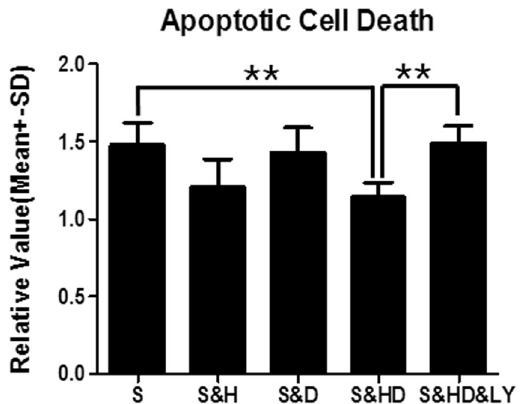
Figure 4. Alleviation of stroke-induced apoptosis (n = 6 per group) with mild hypothermia and C + P combination therapy. ANOVA analyses indicated that combination therapy (S&HD) significantly ( ** P < 0.01) reduced apoptotic cell death. Monotherapy with mild hypothermia (S&H) only displayed a slight reduction in apoptotic death ( * P < 0.05), while C + P monotherapy (S&D) did not significantly increase cell survival. Treatment with p-Akt inhibitor (LY294002) (S&HD&LY) reversed the combination therapy’s effect in neurological improvement ( ** P <